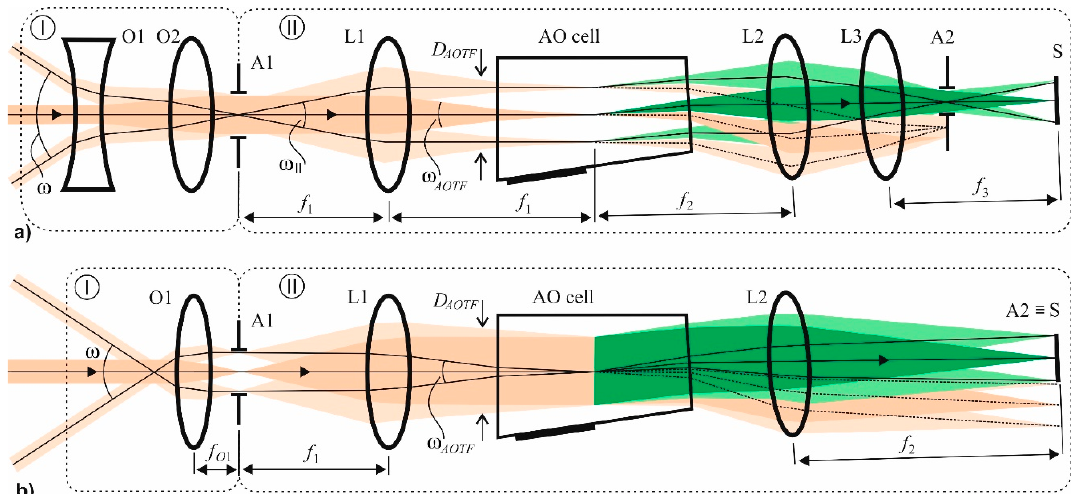
Figure 5. Confocal ( a ) and collimating ( b ) polarizer-free schemes of AOTF-based imagers.